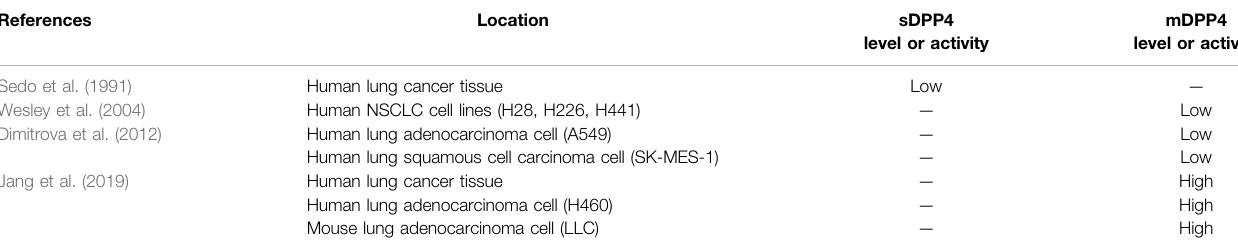
TABLE 2 | DPP4 expressions in lung cancer tissue or